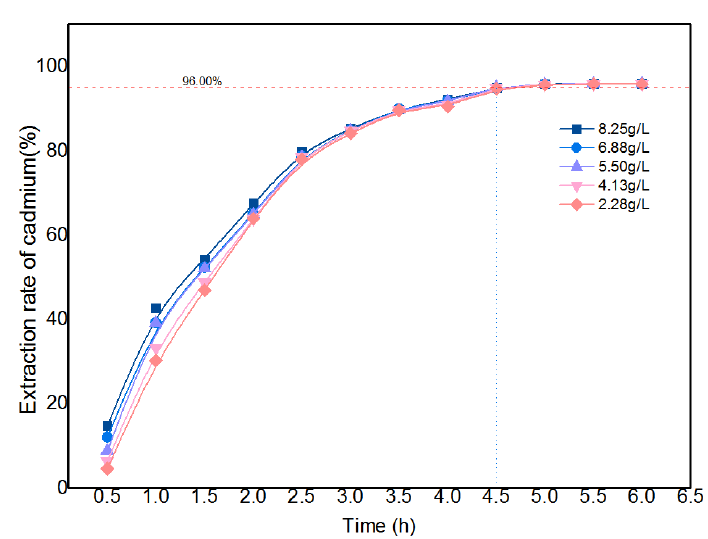
Figure 4. The cadmium extraction rates for continuous monitoring at different initial concentra- tions.